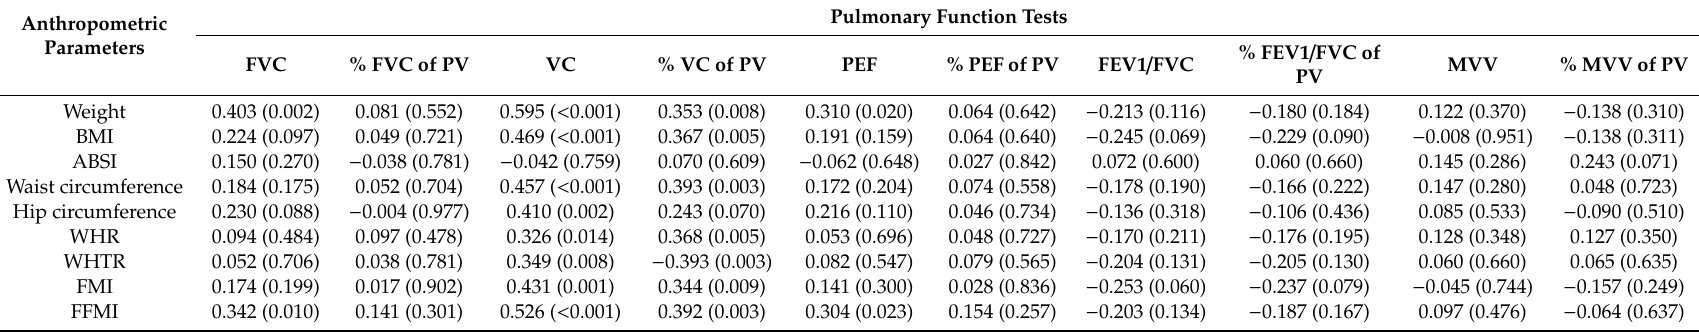
Table 5. Bivariate analysis between PFT parameters and anthropometric parameters in females (n = 66), Pearson correlation coe ffi cient ( p value). Anthropometric